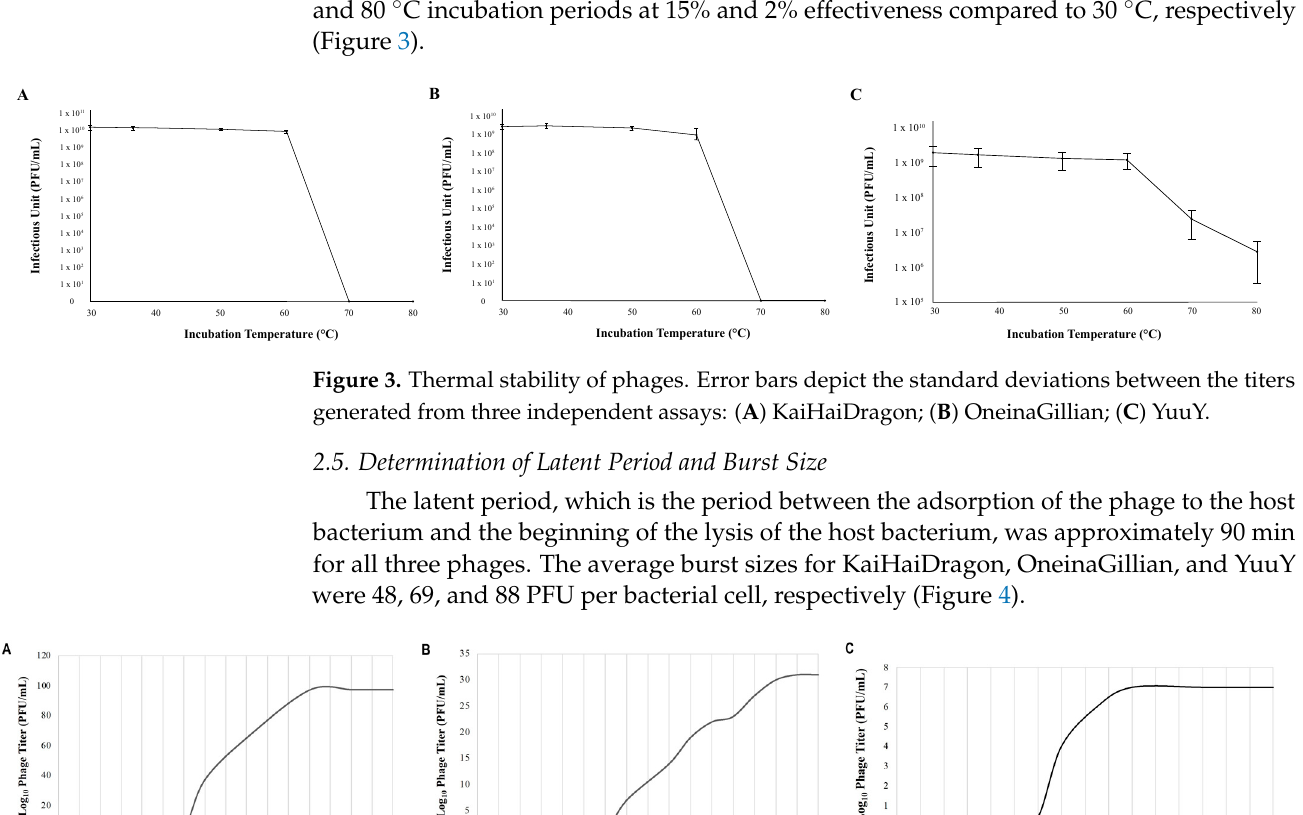
Figure 2. pH stability of phages. Error bars depict the standard deviations between the titers gener-